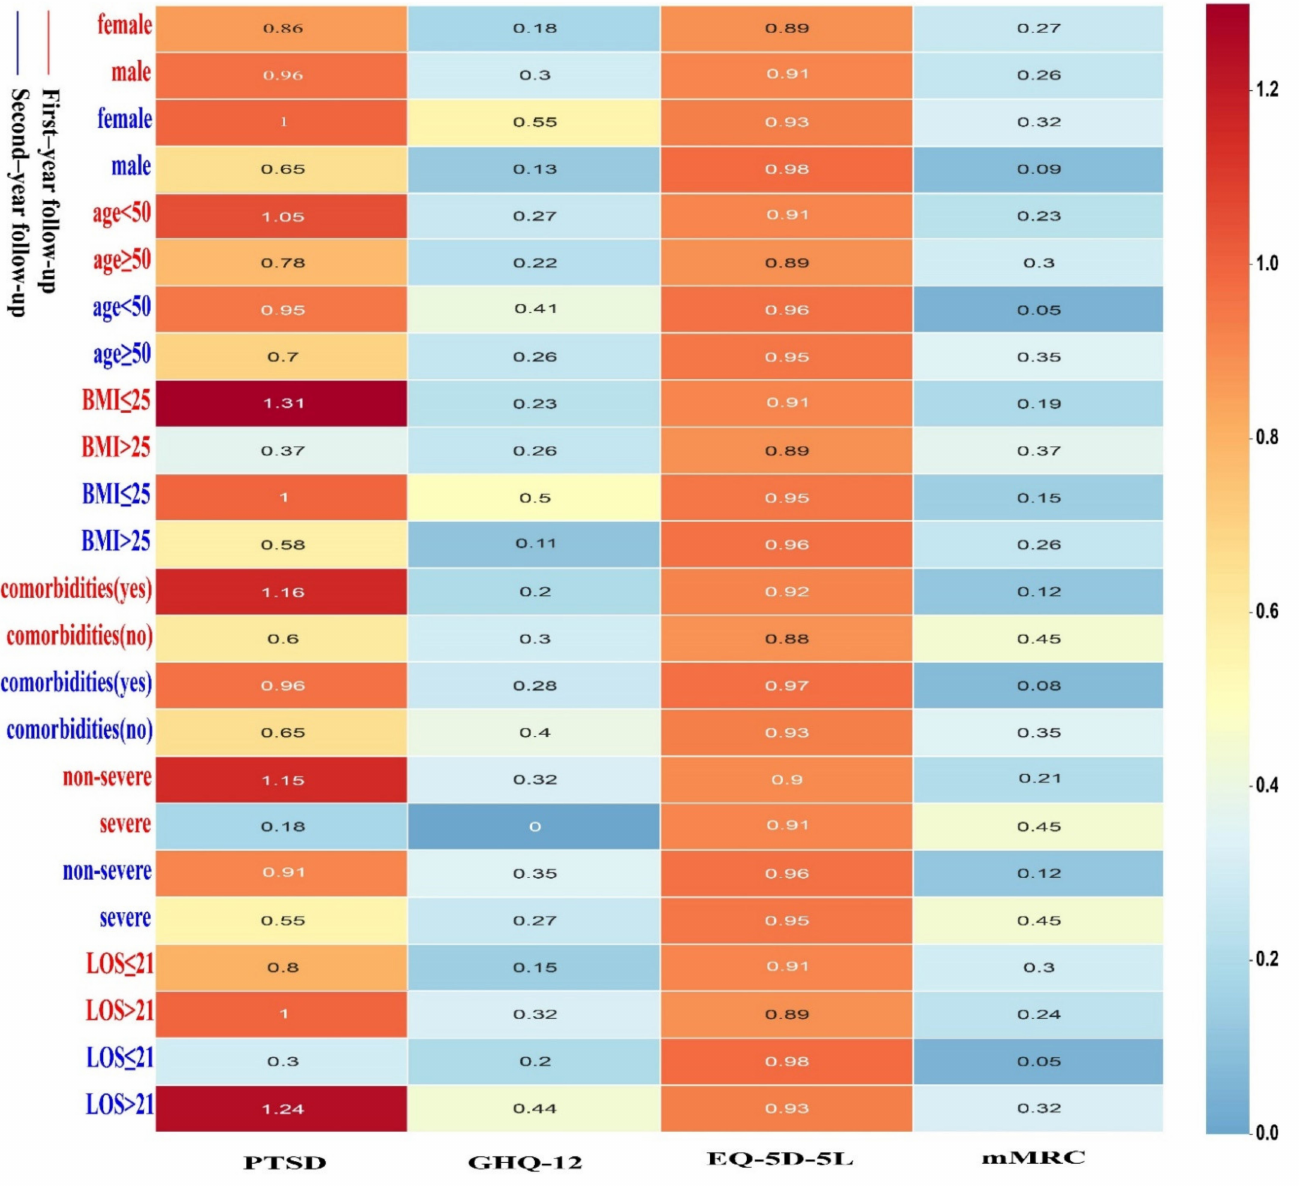
Figure 3. Changes in the scale scores of the 45 subjects in the first and second years classified by sex, age, BMI, comorbidities, disease severity, and LOS. Note: Mann-Whitney U test was used to analyze the differences of each scale in subgroups in the first and second year: female vs. male (0.93 vs. 0.98, p = 0.045) and LOS ≤ 21 vs. LOS > 21 (0.98 vs. 0.93, p = 0.034) in scales of EQ-5D-5L in the second year, comorbidities (yes) vs. comorbidities (no) (0.12 vs. 0.45, p = 0.029) in scales of mMRC in the first year, and BMI ≤ 25 vs. BMI > 25 (0.15 vs. 0.26, p = 0.025) in scales of mMRC in the second